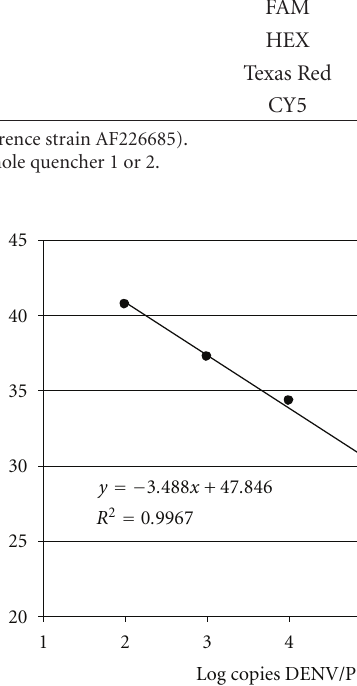
Figure 1: The dynamic range of generic of PCR. Mean Cq-values of twelve replicates per each 10-fold dilutions of DENV in vitro RNA extracted with a fixed amount of 6 . 25 × 10 3 IC copies in extraction in the back ground of DENV negative serum and tested in generic real-time PCR resulting in a dynamic range of 6 . 25 × 10 3 –6.25 × 10 7 copies/mL of DENV in vitro RNA with a regression coe ffi cient of